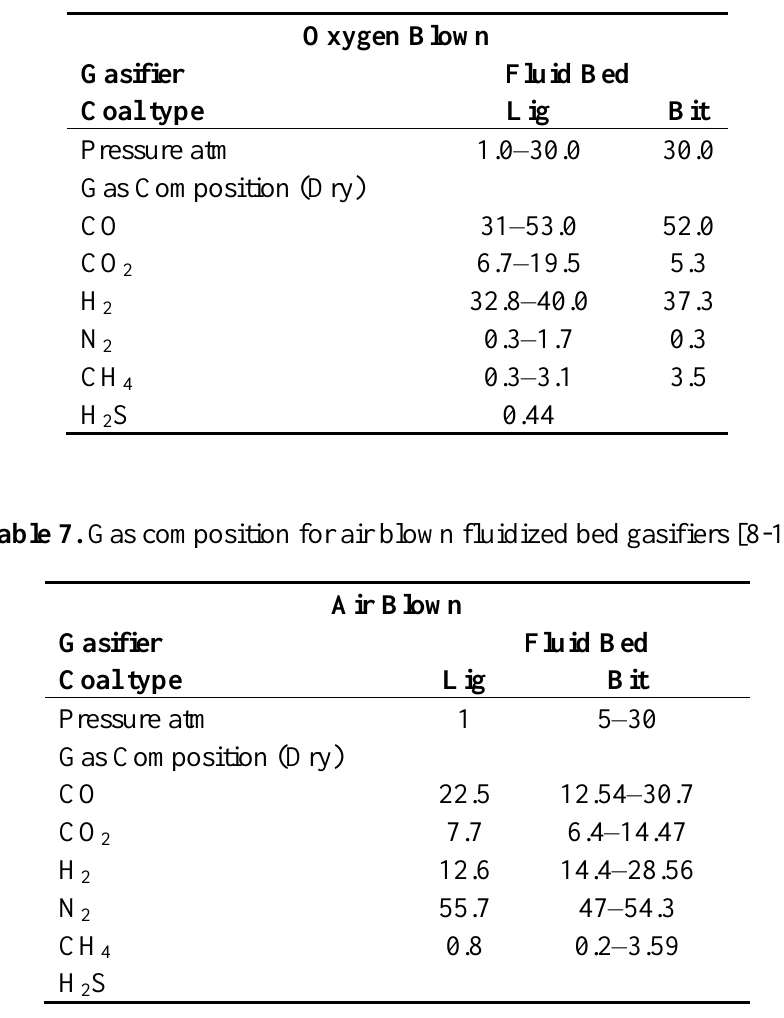
Table 6. Gas composition for oxygen blown fluidized bed gasifiers [7-10].